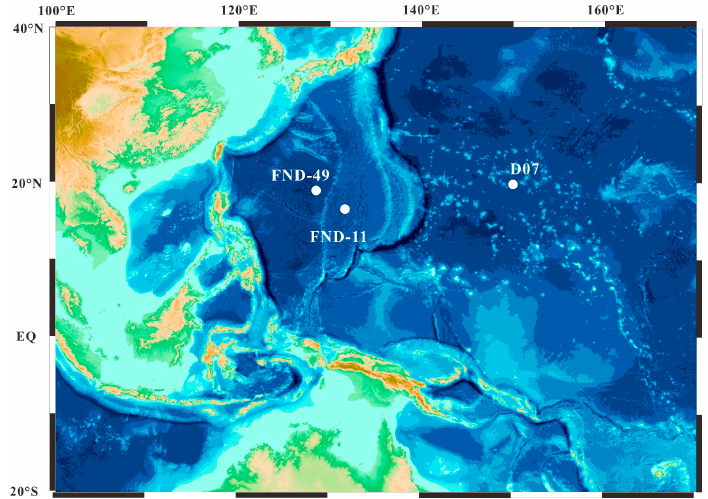
Figure 1. Location map for this study. The white circles are sites FND-11, FND-49 and D07.